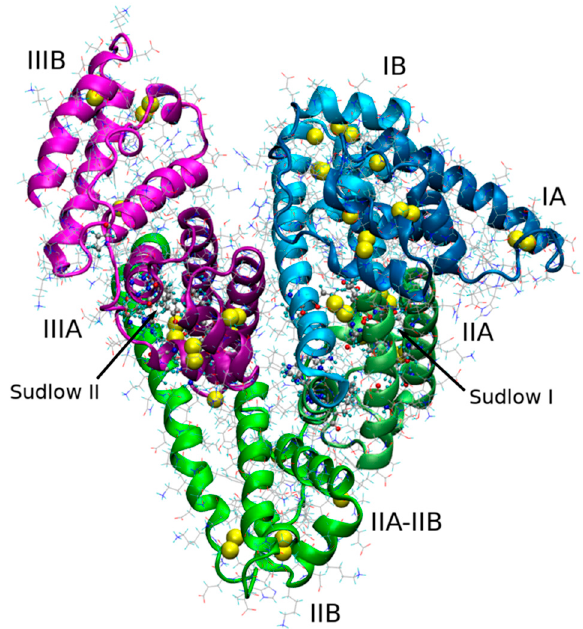
Figure 1. Structure of HSA downloaded from RCSB Protein Data Bank (PDB ID: 1AO6).